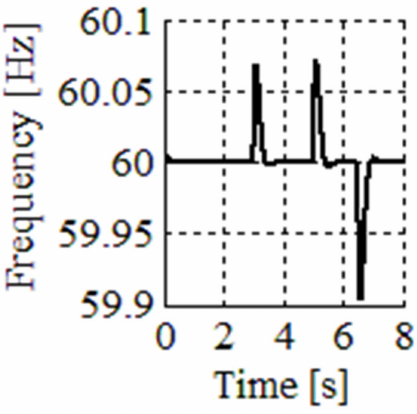
Figure 8. Frequency signal of the regulation loop with the three-phase